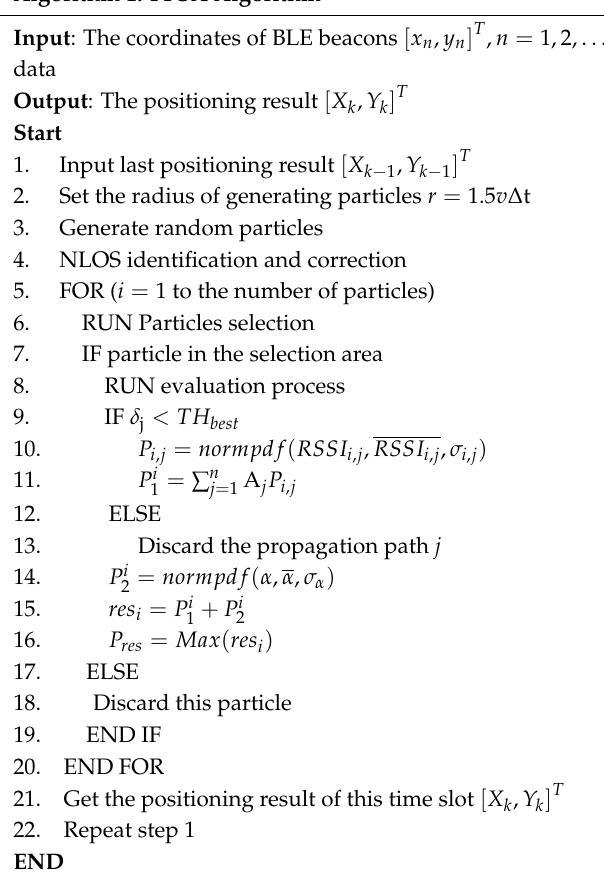
Algorithm 1: PPSA